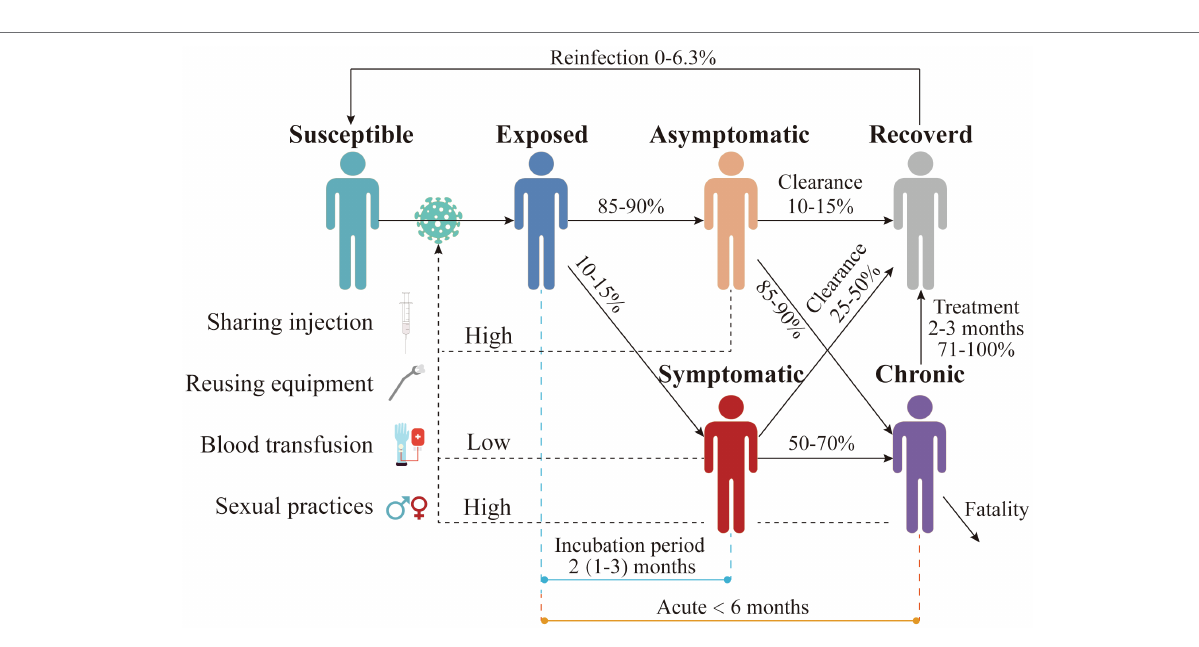
FIGURE 5 | Natural history of HCV infection in humans. People with different colors indicate the infection status of HCV. The solid lines represent the transition of each status, and the numbers above them represent the transition ratio or time. The dotted lines indicate the main transmission routes. “High” means the main transmission route, and “low” means the secondary